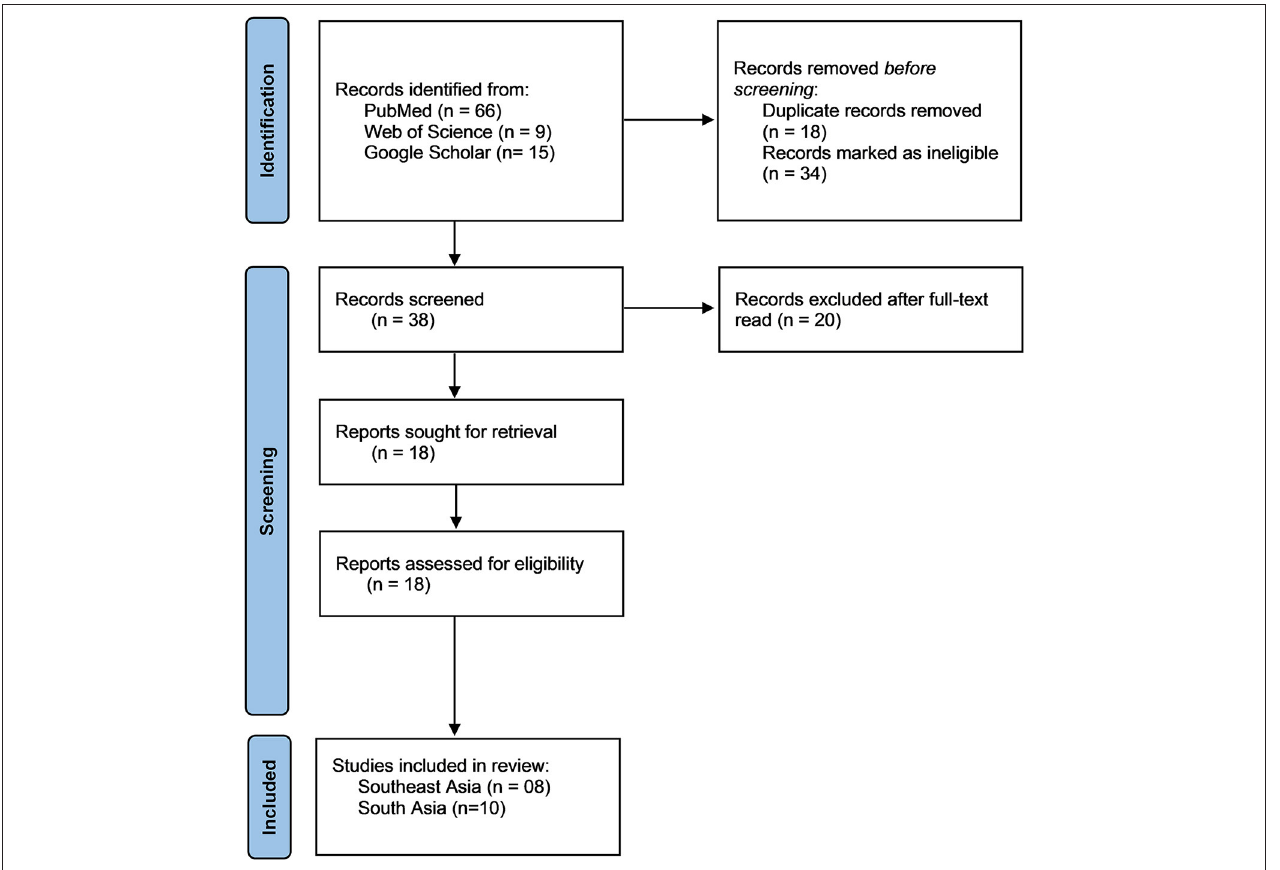
Data Screening and